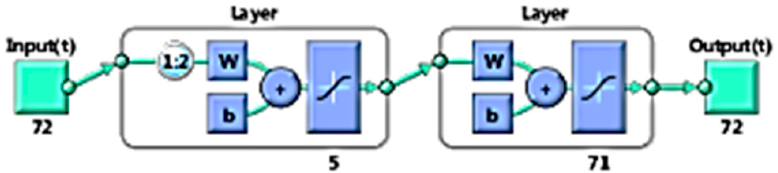
Figure 8. The general structure of TDNN.